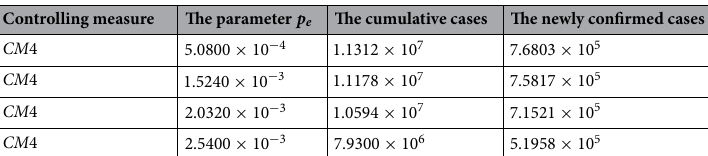
Table 13. The effect of the CM 4 on the cumulative cases.